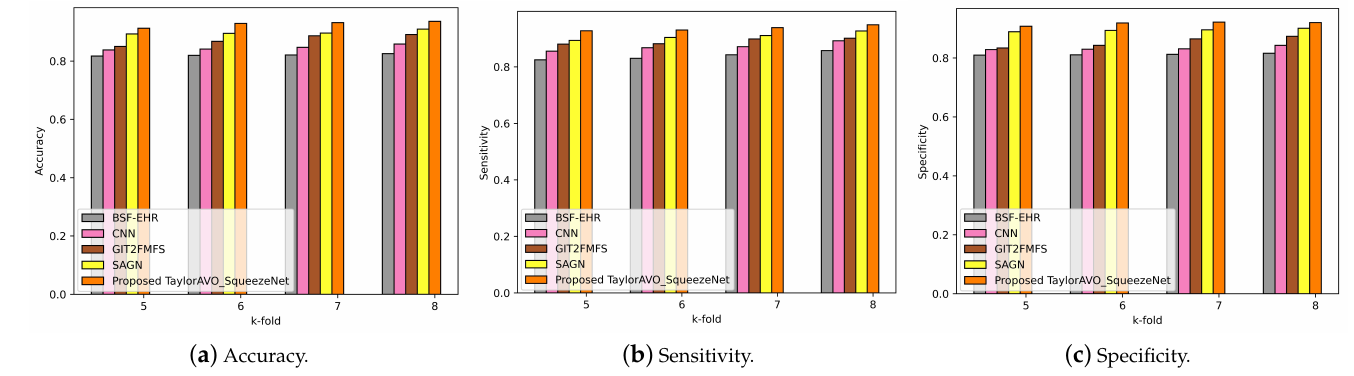
Figure 4. Evaluation of accuracy, sensitivity, and specificity using TaylorAVO-SqueezeNet with other traditional models according to varying k-fold validation.